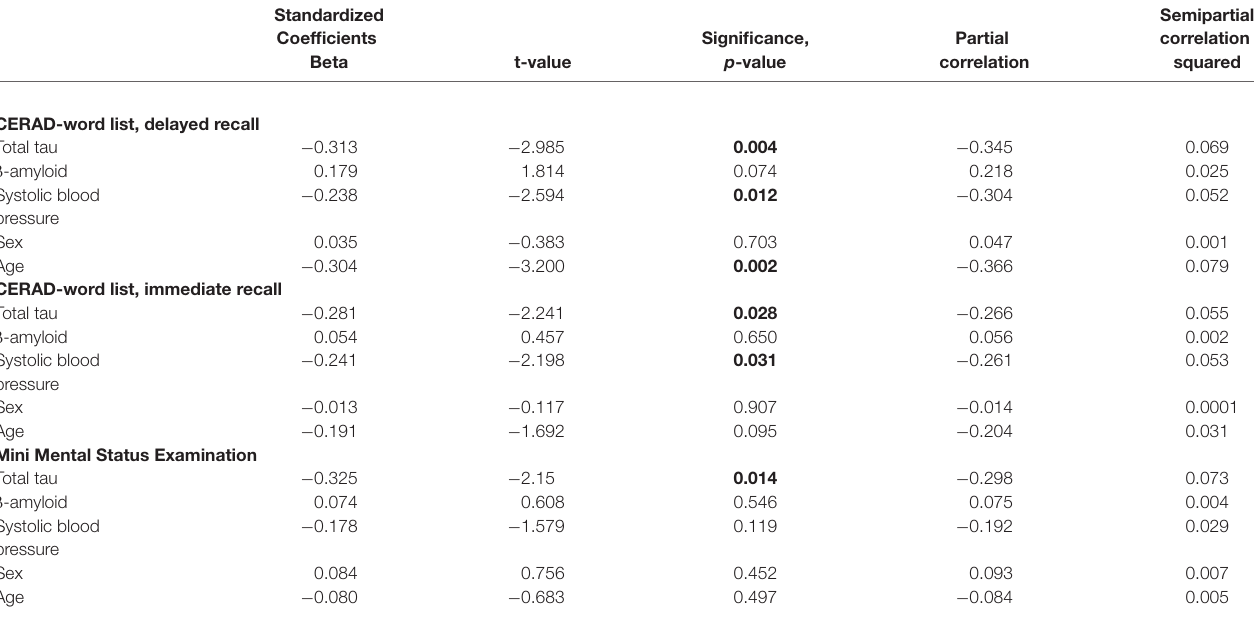
TABLE 2 | Standardized Beta, t-value, p-value, partial correlation, and the squared semipartial correlation to indicate the unique variance explained by each variable for the independent